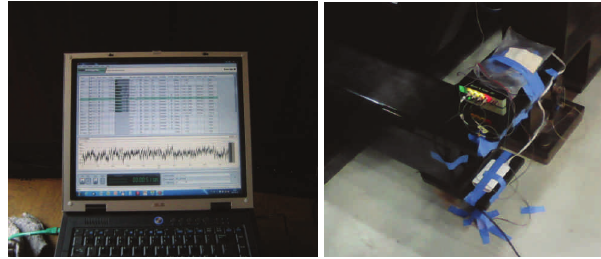
Fig. 3. View of the measurement equipment on the test stand